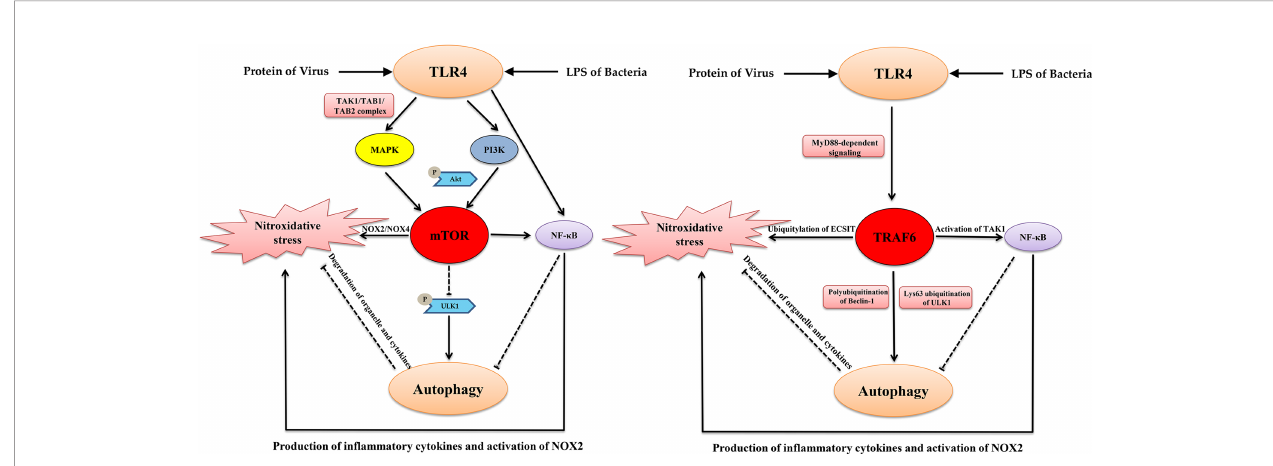
FIGURE 1 | The key signaling nodes that link TLR4, autophagy and nitroxidative stress. TLR4, Autophagy, and Nitroxidative Stress: A Triangular Relationship That Affects Cellular